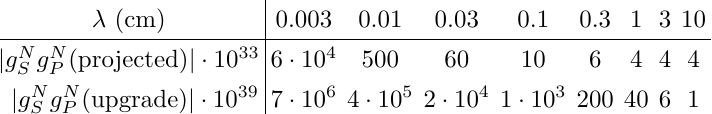
Table 12 . The projected limits on the strength of the axion mediated monopole-dipole interaction from the ARIADNE experiment using the initial and upgraded setups of ref. [130].